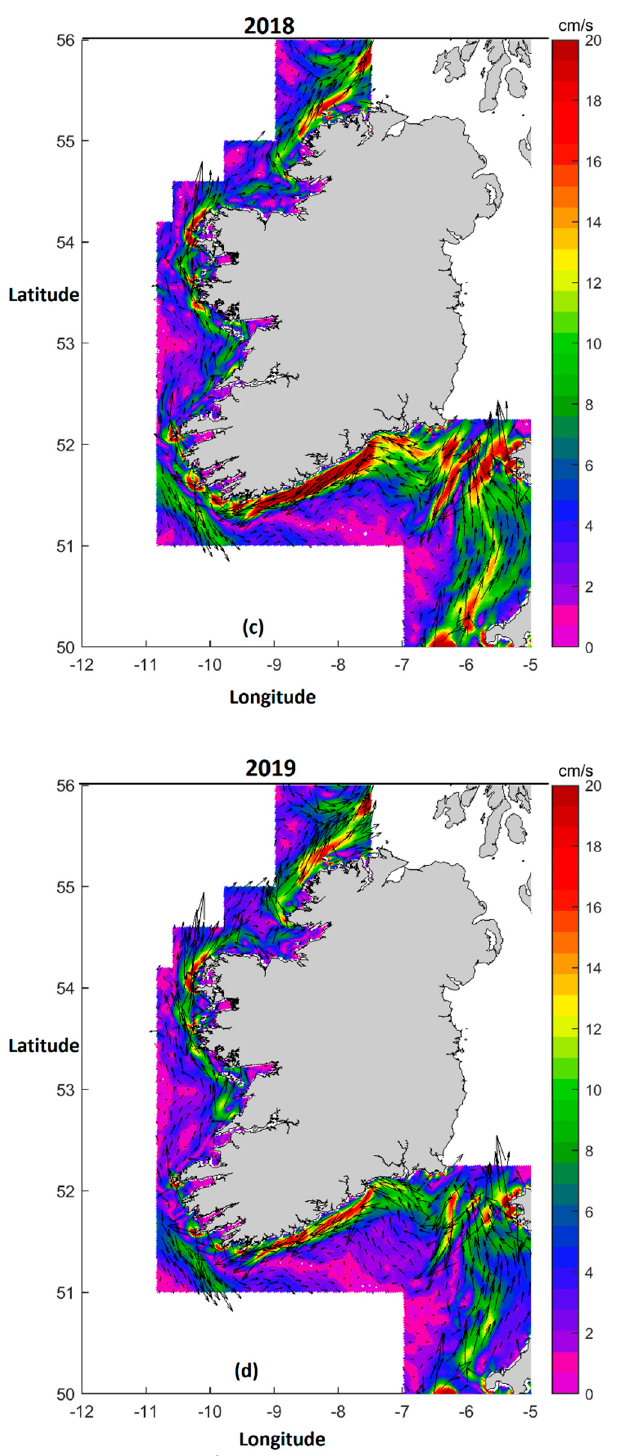
Figure 10. Magnitude current maps for NEA_ROMS Model describing the Irish Coastal Current in [cm / sec] for the model simulation period from 2016 until 2019 where; ( a ) 2016 ( b ) 2017 ( c ) 2018 ( d ) 2019.